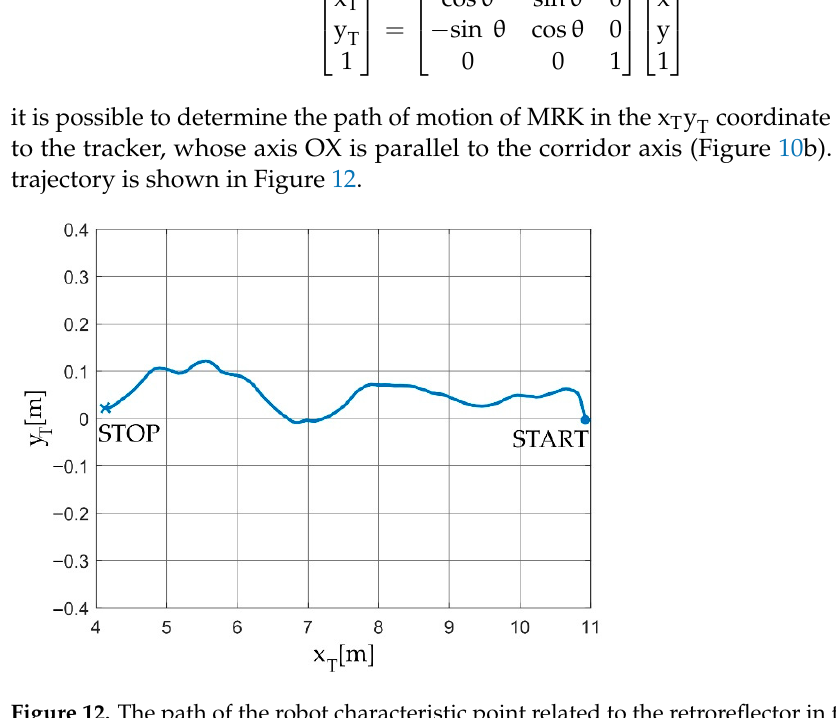
Figure 12. The path of the robot characteristic point related to the retroreflector in the transformed coordinate system.